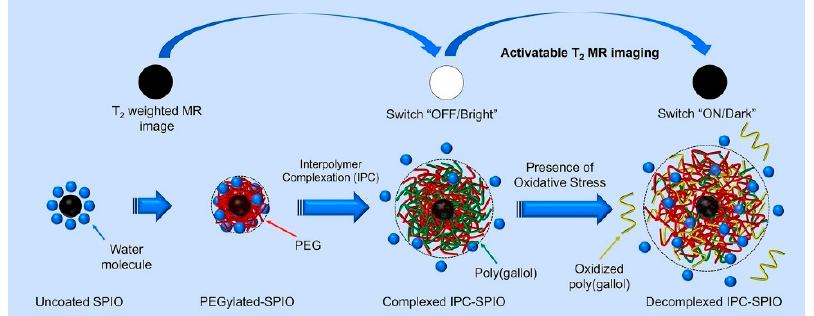
Figure 4. Illustration of activatable interpolymer complex-superparamagnetic iron oxide nanopar- ticles. SPIO: Superparamagnetic iron oxide nanoparticles; IPC-SPIO: Interpolymer complex-super- paramagnetic iron oxide nanoparticles. Reprinted (adapted) with permission from [47]—Pub- lished by Elsevier .